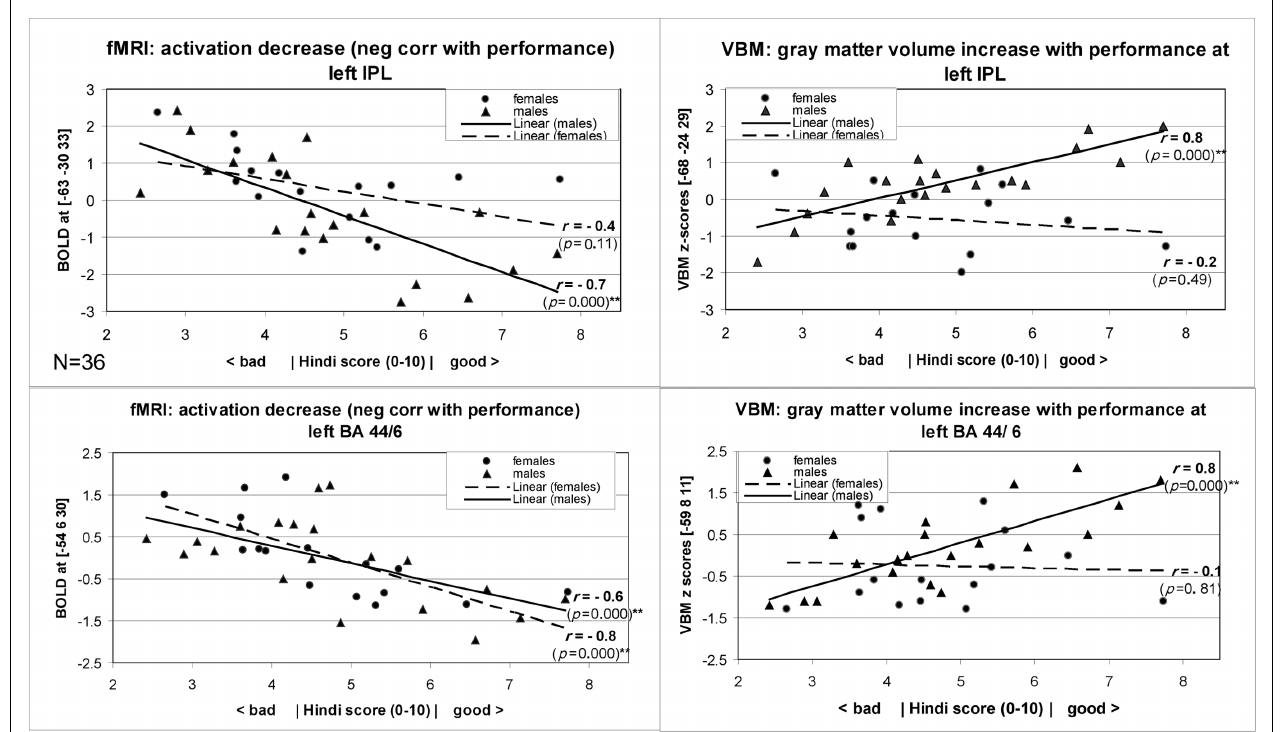
results; i.e., a gray matter volume increase, within the same clusters (left IPL - upper picture, left IFG lower picture), with Hindi imitation scores, however, is significant only for the male group (black solid lines). Males are represented by regression lines in black and black triangles, females by gray dashed lines and gray